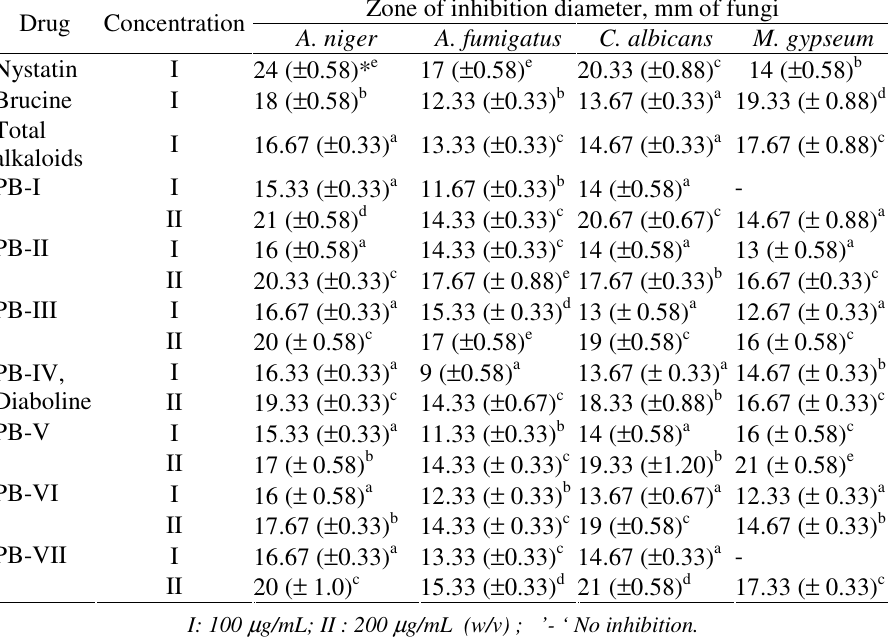
Table 2 . Antifungal activity of S. potatorum alkaloid fractions.